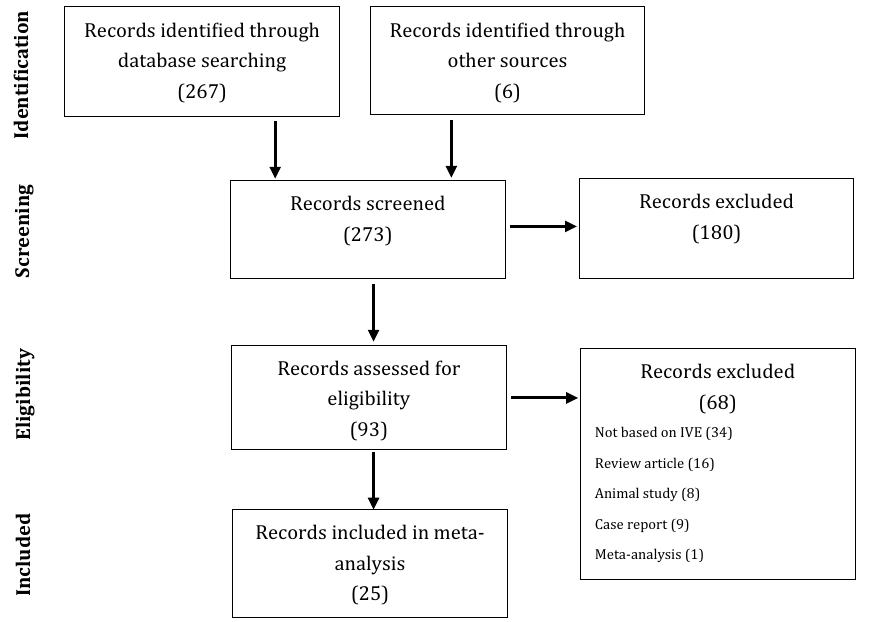
Figure 1. Flow chart depicting the study selection process (PRISMA flow